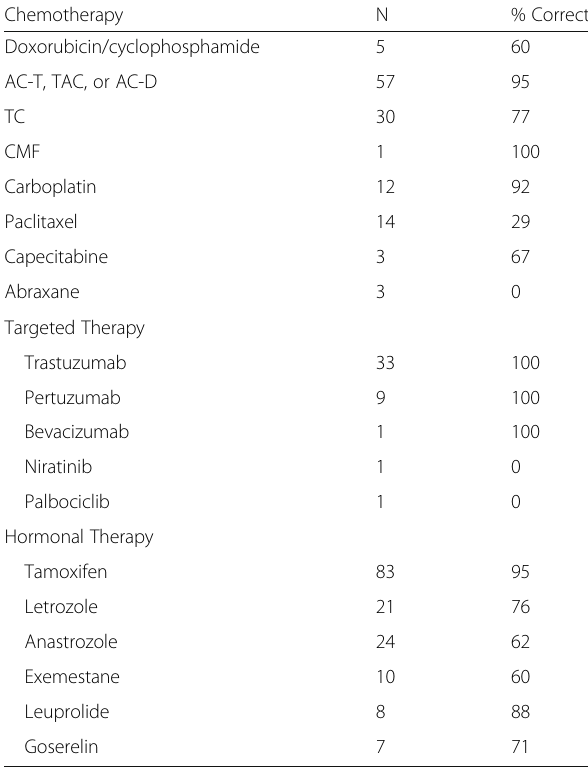
Table 2 Accuracy of patient-reported receipt of specific